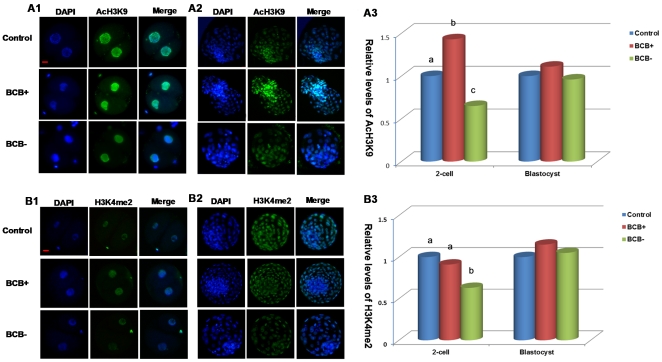
Global acetylation levels of H3K9 and global methylation levels of H3K4 in SCNT embryos.Staining of AcH3K9 (A) and H3K4me2 (B) in control, BCB+, and BCB− embryos at the two-cell (A1 for AcH3K9 and B1 for H3K4me2) and blastocyst stage (A2 for AcH3K9 and B2 for H3K4me2). Each sample was counterstained with DAPI to visualize DNA (blue). Original magnification was ×200. Bar = 20 µm. Quantification of AcH3K9/DNA (A3) and H3K4me2/DNA (B3) signal intensities in control (blue bars), BCB+ (red bars), and BCB− (green bars) embryos at the two-cell and blastocyst stage. Labeling intensity was expressed relative to that of the control embryos (set as 100%). Quantification of the AcH3K9/DNA and H3K4me2/DNA ratio is represented as the mean ± SEM. Values with different superscripts differ significantly (P<0.05). The experiments were replicated three times. In each replication, n = 10–15 per group.